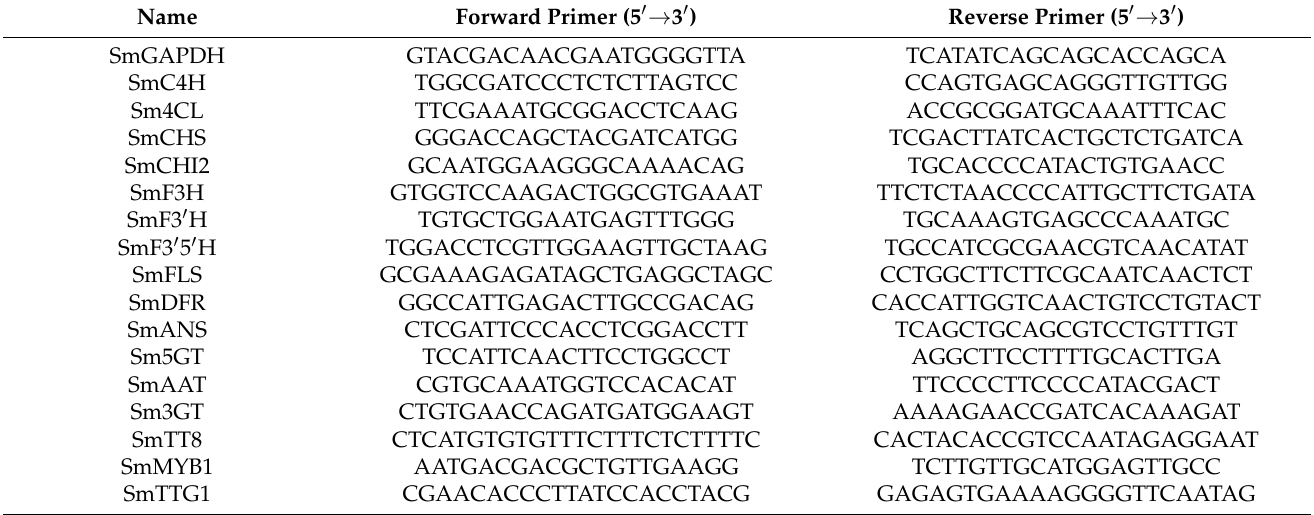
Table 1. The sequences of the primers used for qRT-PCR in this